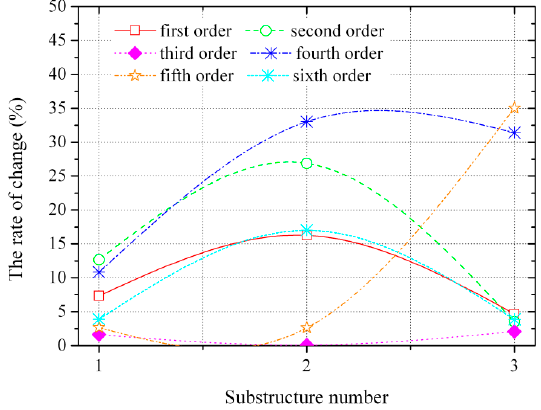
Figure 11. Change rates of the first six modal frequencies with the cross-section stiffness of the substructure.